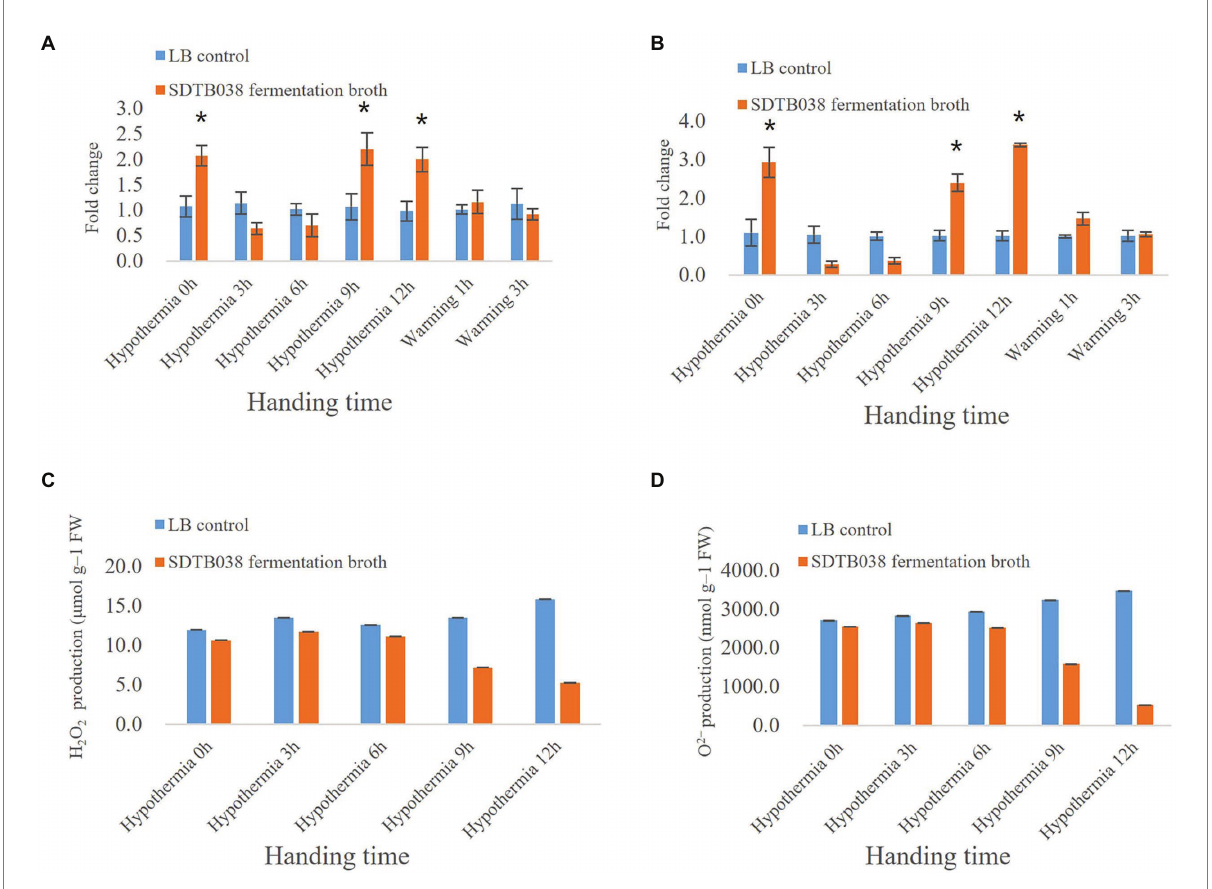
FIGURE 5 Expression of enzyme activity genes and changes of H 2 O 2 and O 2 − Content. (A) CAT expression; (B) SOD expression; (C) Changes of H 2 O 2 Content; (D) Changes of O 2 − Content. Asterisks indicate significant differences between tomato plants inoculated with SDTB038 broth and those inoculated with liquid LB. The different lowercases represent significant level ( p = 0.05) according to the Duncan’s